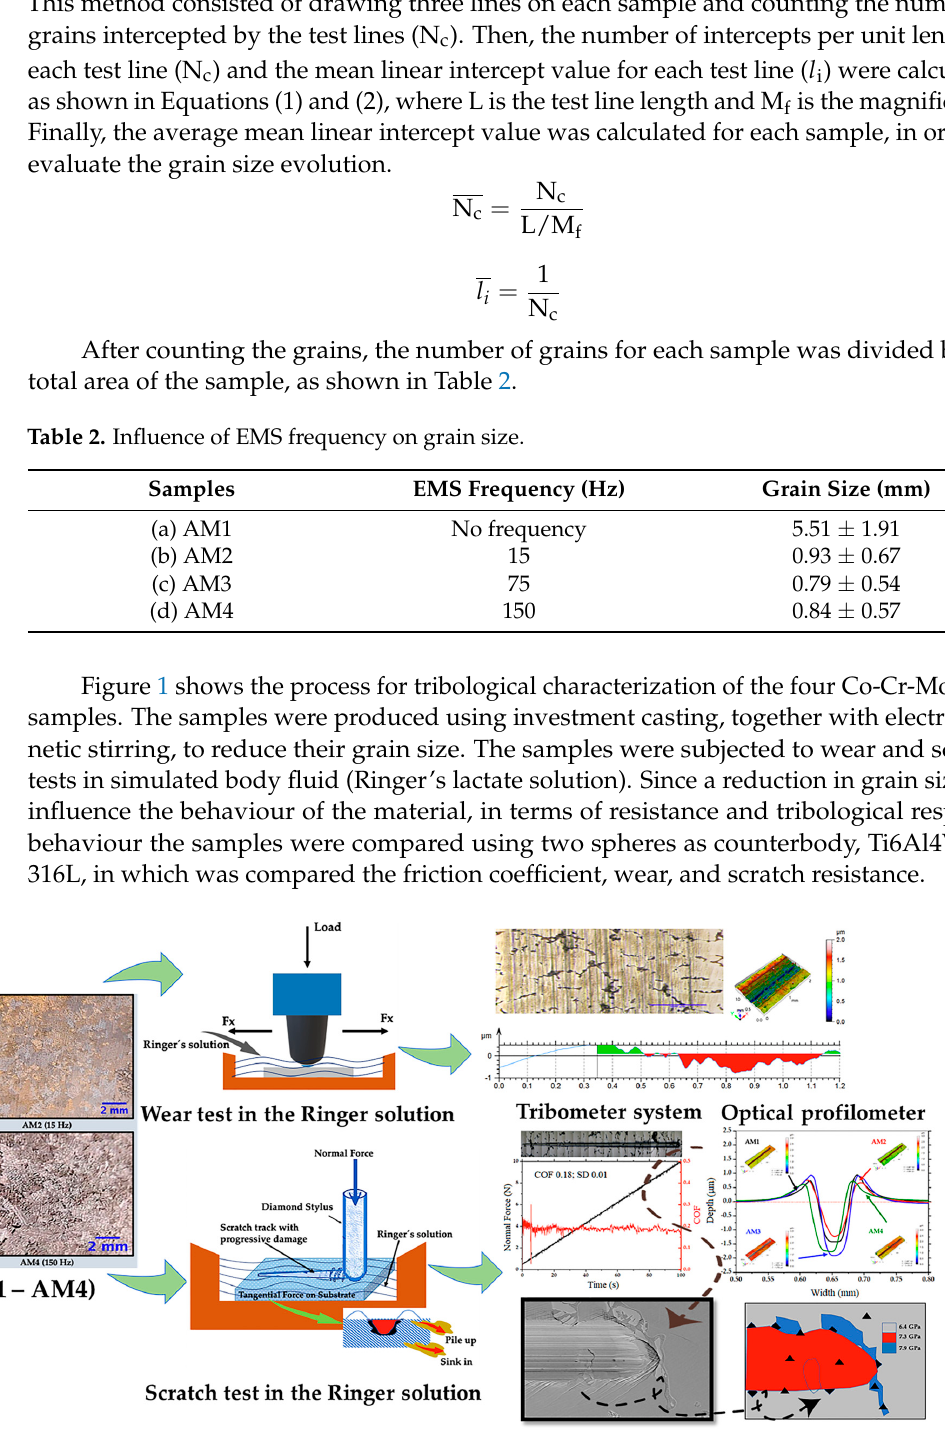
Figure 1. Scheme for tribological testing of the Co-Cr-Mo alloy samples.